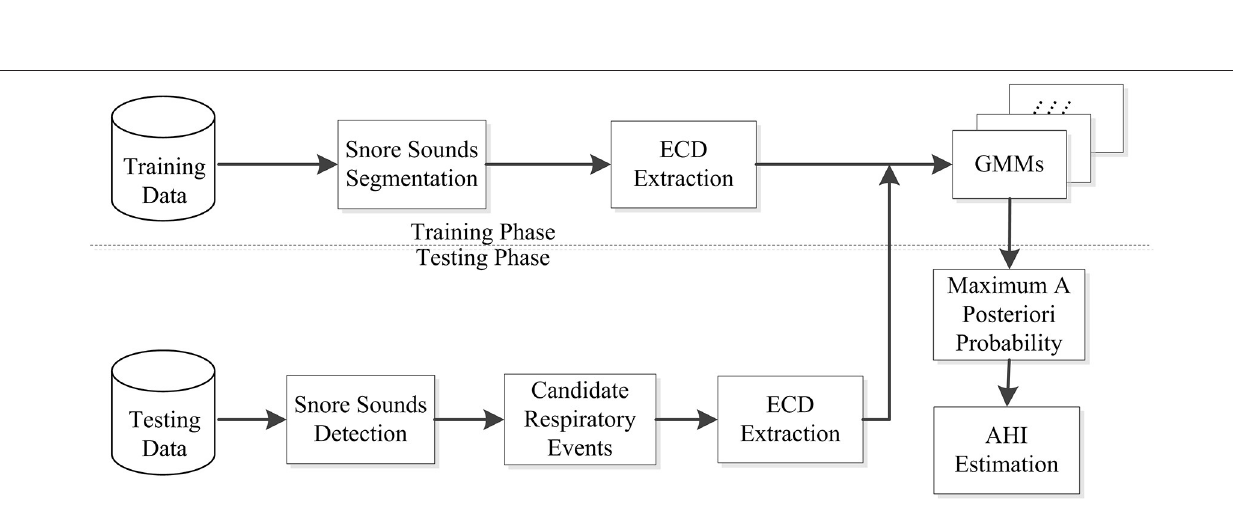
FIGURE 5 | Flow chart of the snore training and testing